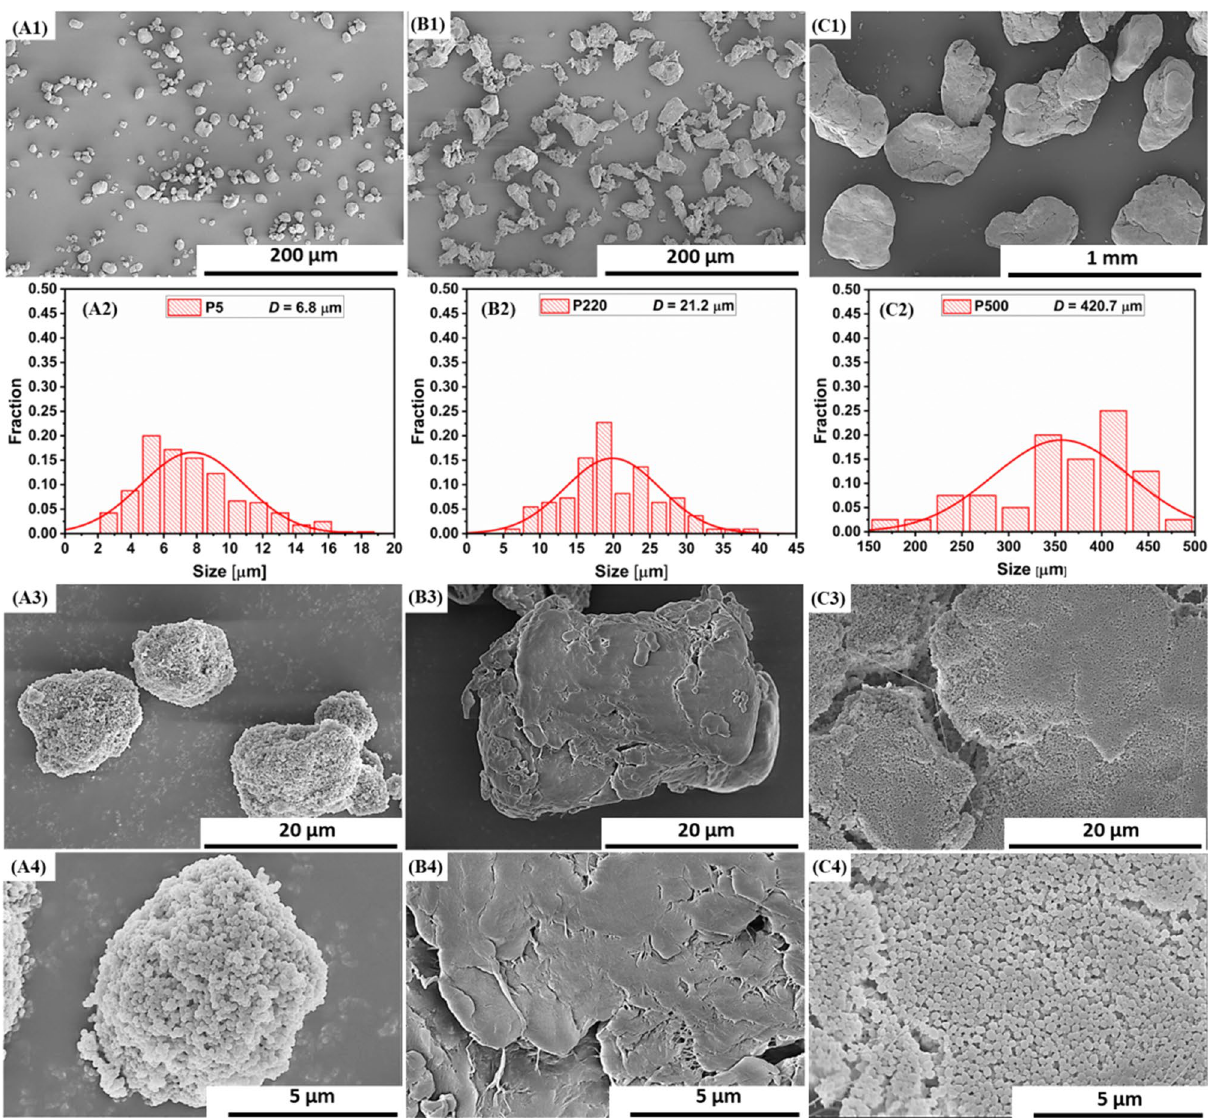
Figure 2. SEM micrographs and size distribution of PTFE powders: ( A ) P5, ( B ) P220, and ( C )